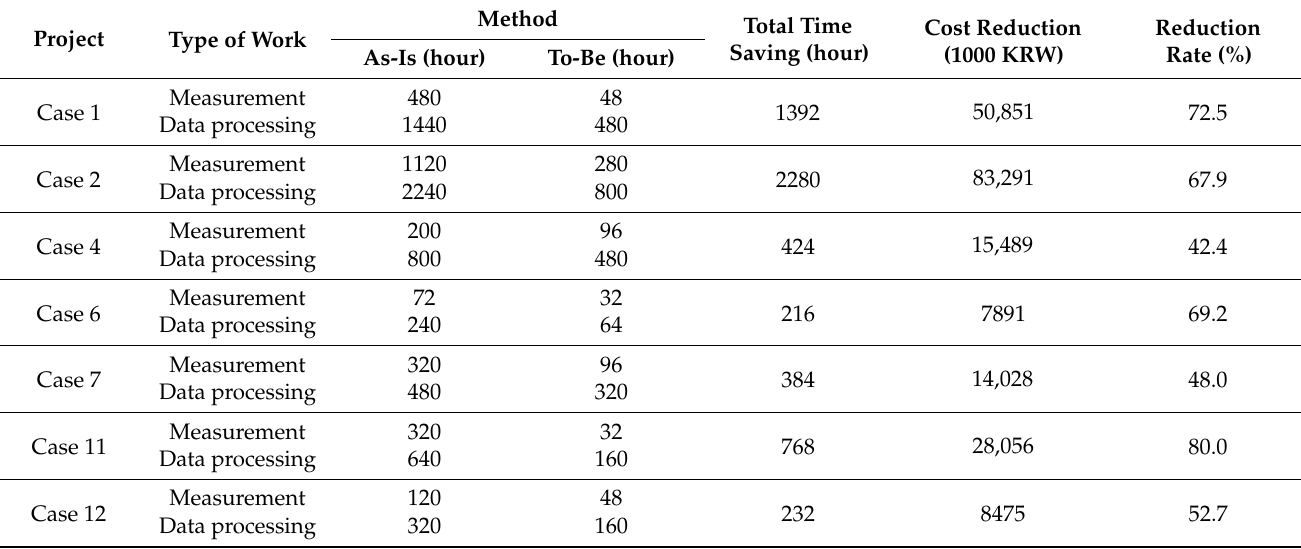
Table 5. Time and cost comparison between the traditional and TLS methods (as-is vs.